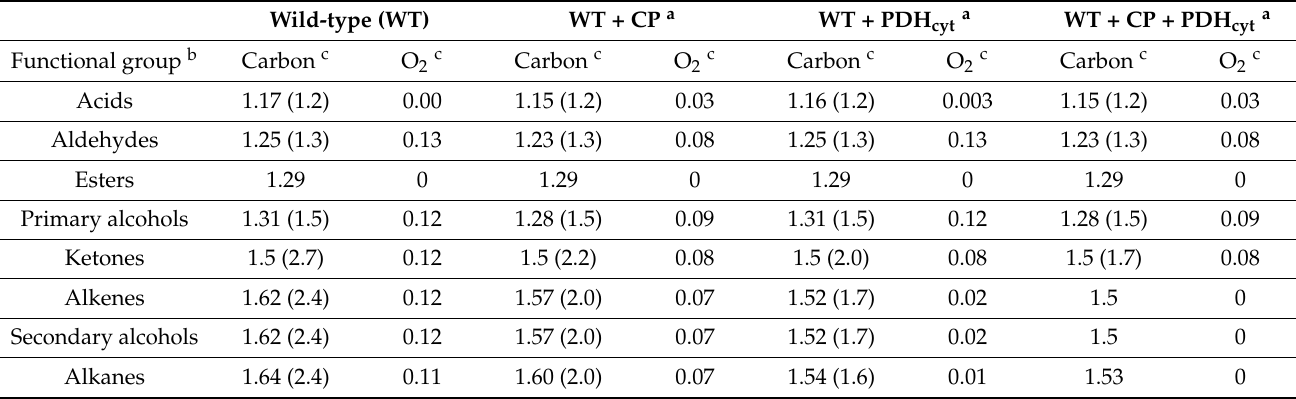
Table 2. Theoretical carbon source and O 2 requirements to produce functionalized hydrocarbons based on wild-type A. sarcoides NRRL 50072 genomic potential and recombinant strains.